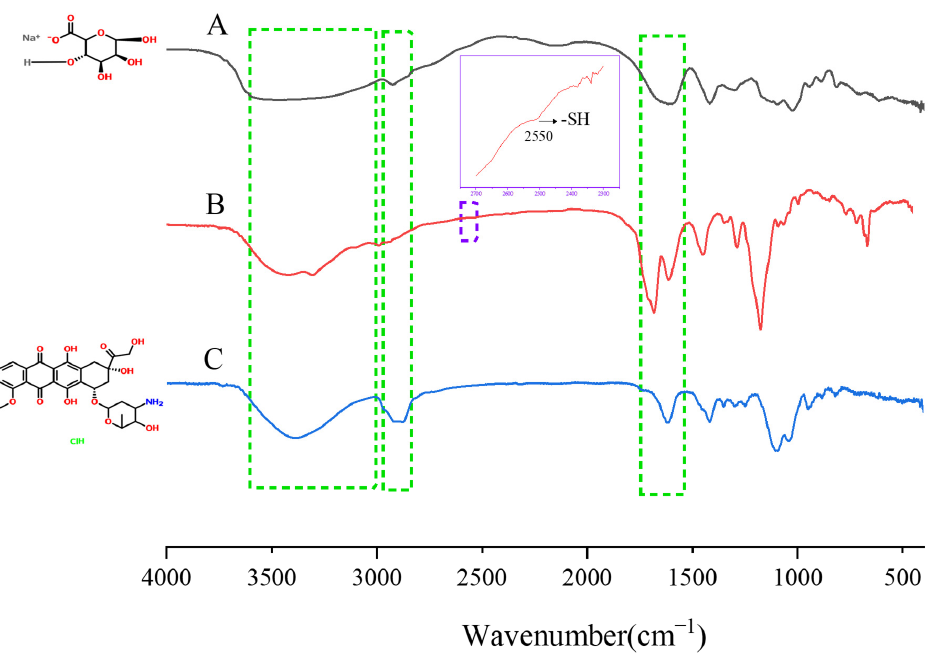
Figure 2. Infrared spectra of samples: A, sodium alginate; B, the prepared dendrimer-modified hydrogel ( Glu-Cys-SAs ); C, dox-loaded Glu-Cys-SAs .